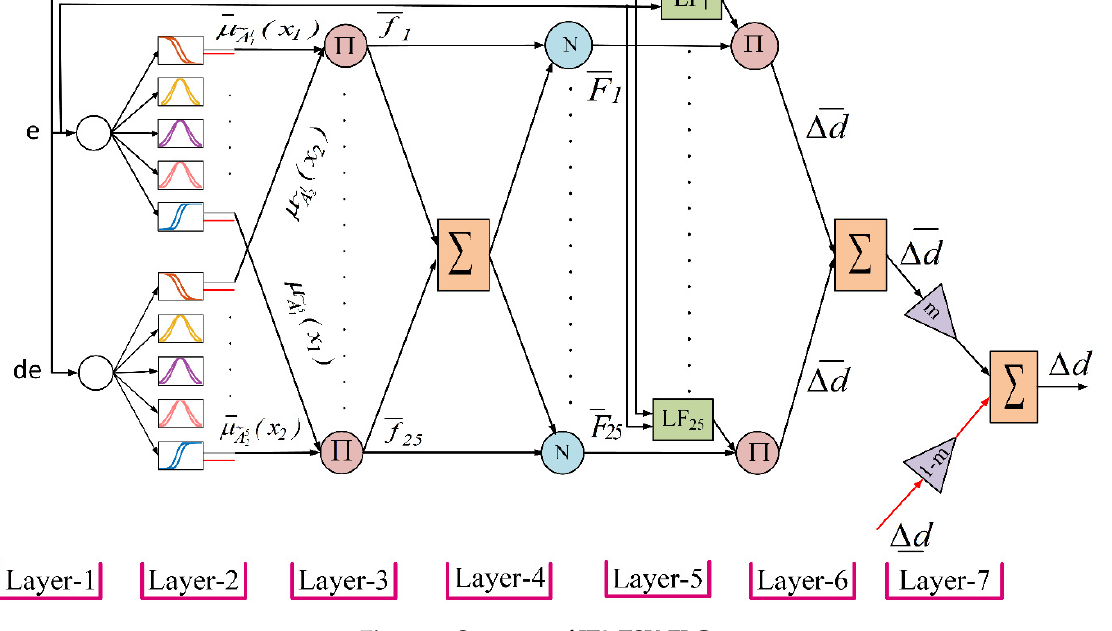
Figure 5. Structure of IT2-TSK-FLC.